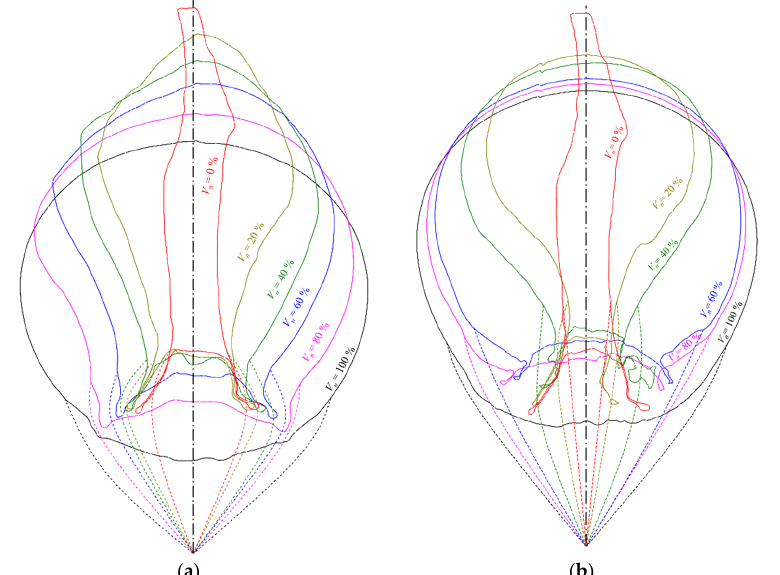
Figure 14. Lines plans of the meridian pro fi le of the models for two dimensions with di ff erent in fl a- tion ratios. ( a ) 1 m model. ( b ) 4 m model. The lines of the 1 m model straps were slightly shorter than the lines in the 4 m airbag